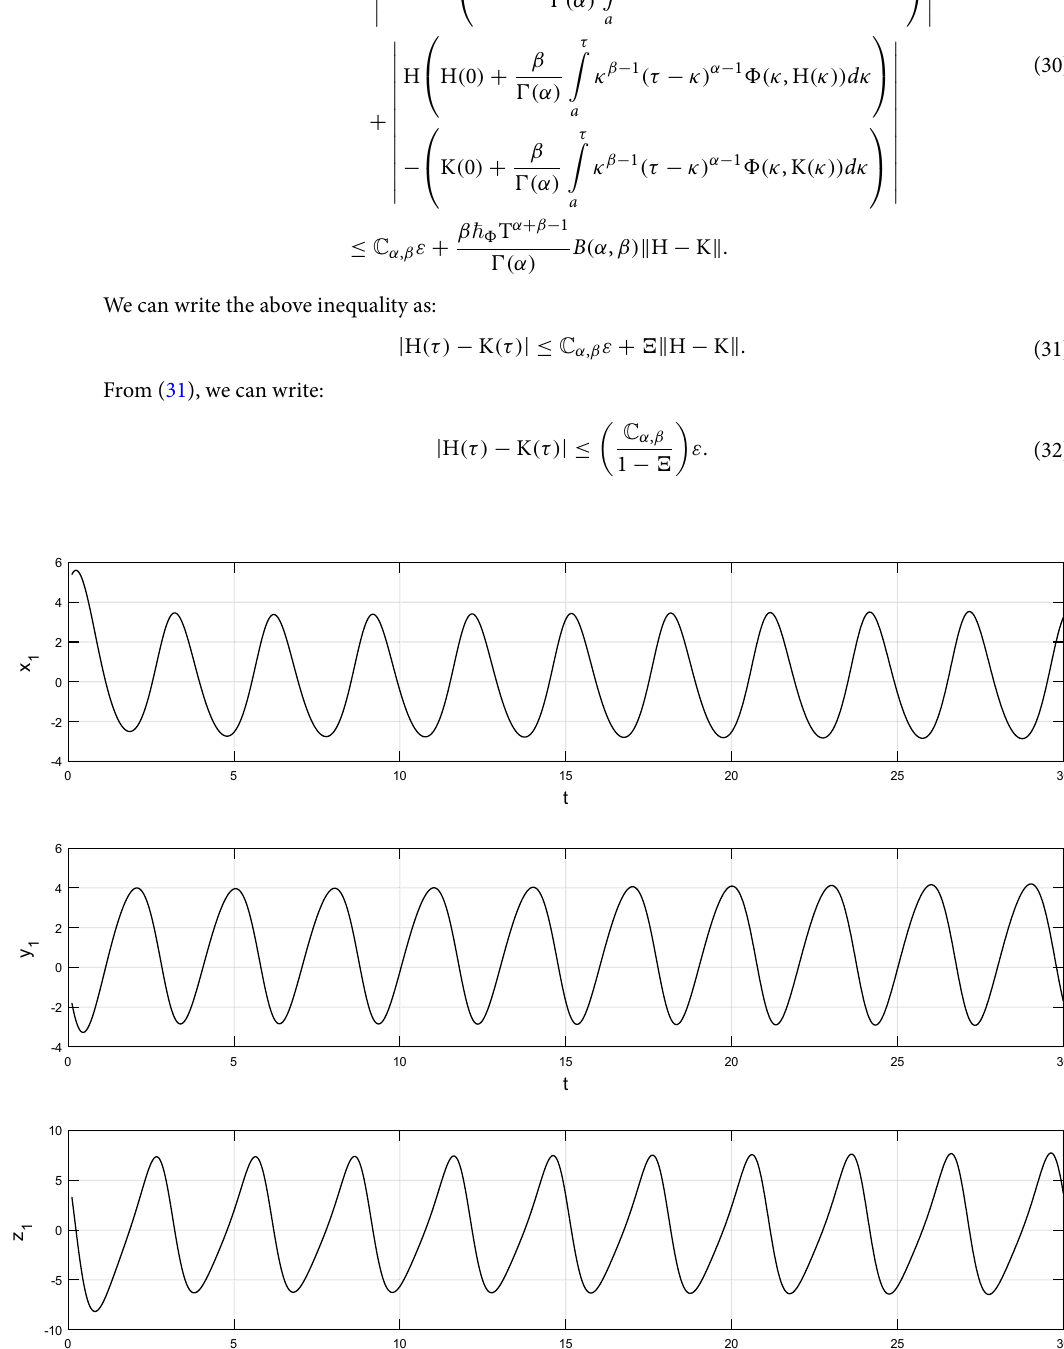
Figure 1. The classical case’s chaotic attractor dynamics i.e., α = β =